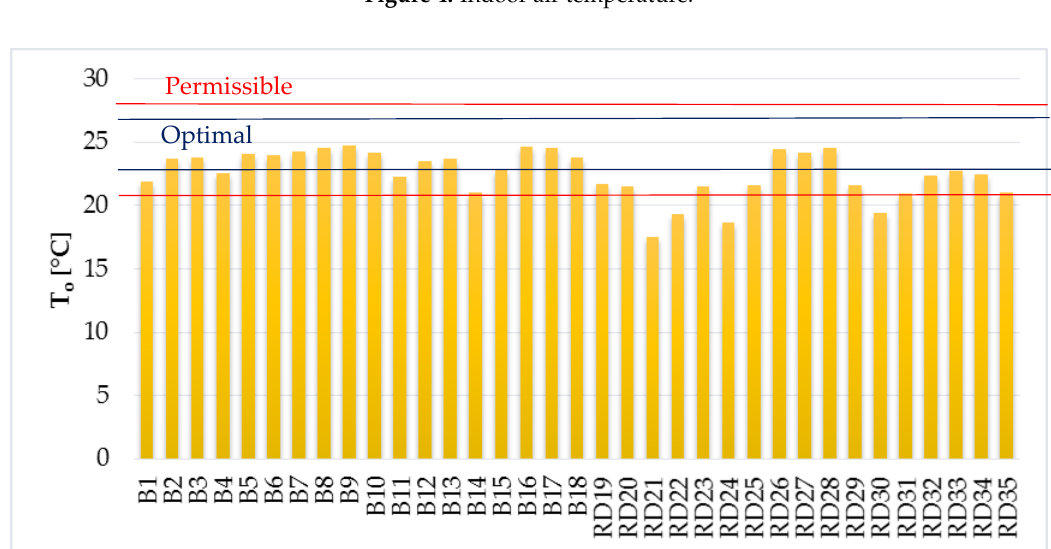
Figure 5. Operative temperature.